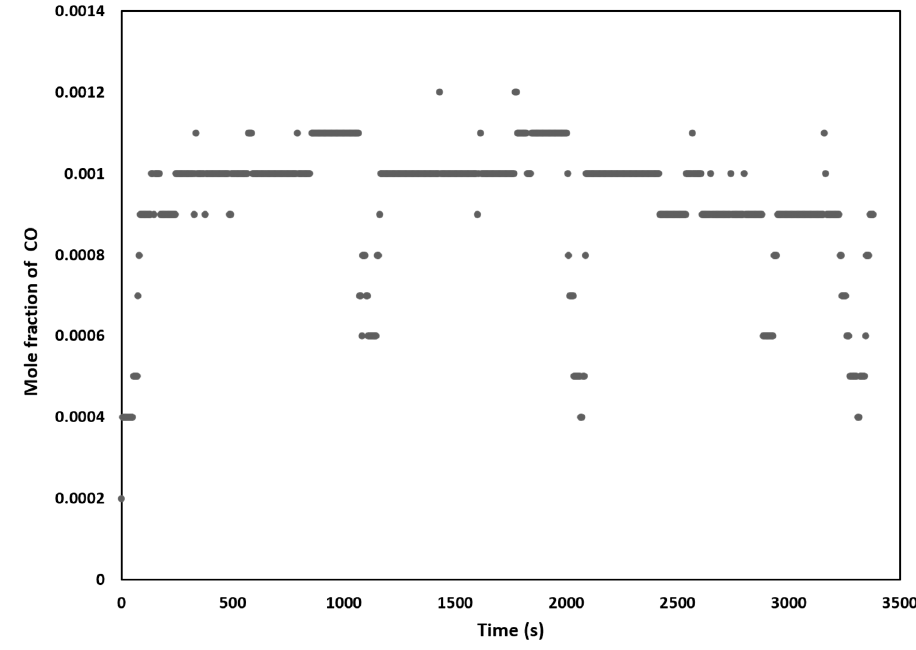
Figure 22. Results of CO measurements during experimentation.